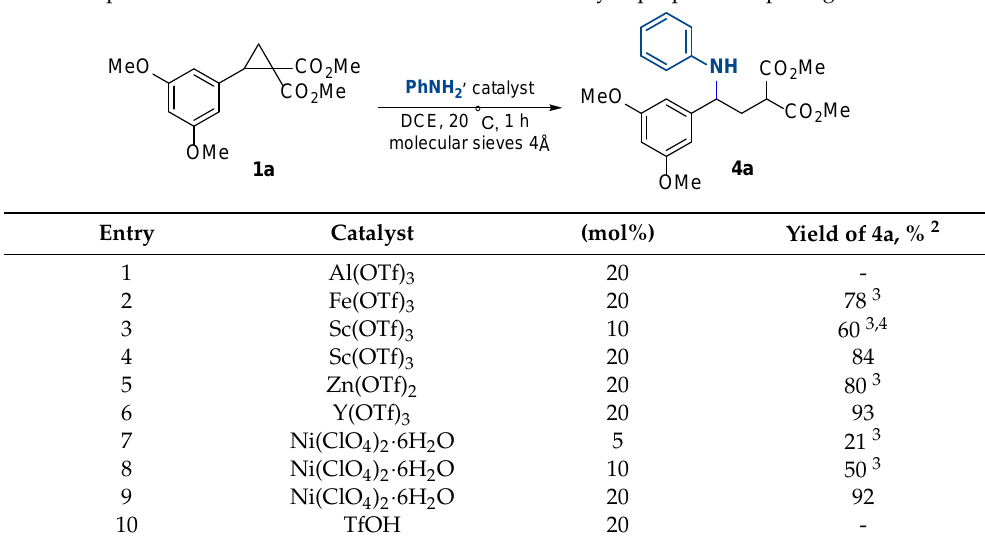
Table 1. Optimization of reaction conditions for the model cyclopropane 1a opening with aniline 1 .